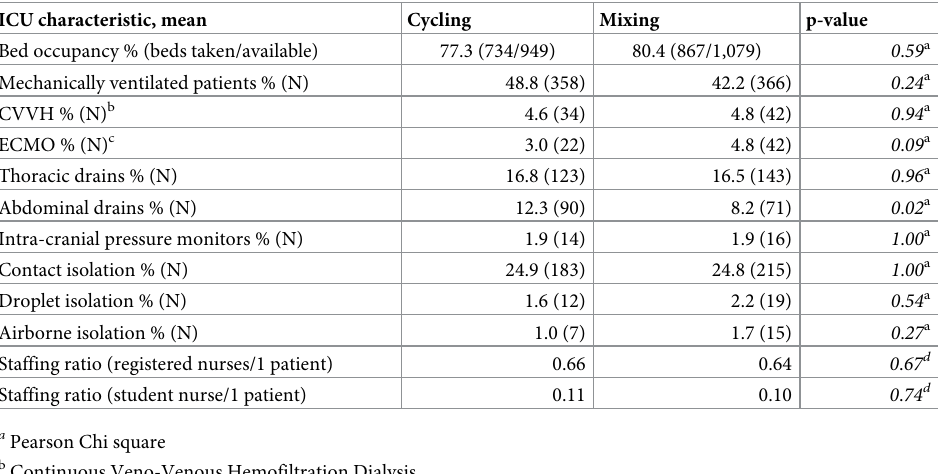
Table 2. Overall ICU characteristics, all admissions during study periods. ICU characteristic, mean Cycling Mixing p-value Bed occupancy % (beds taken/available) 77.3 (734/949) Mechanically ventilated patients % (N) 48.8 (358)